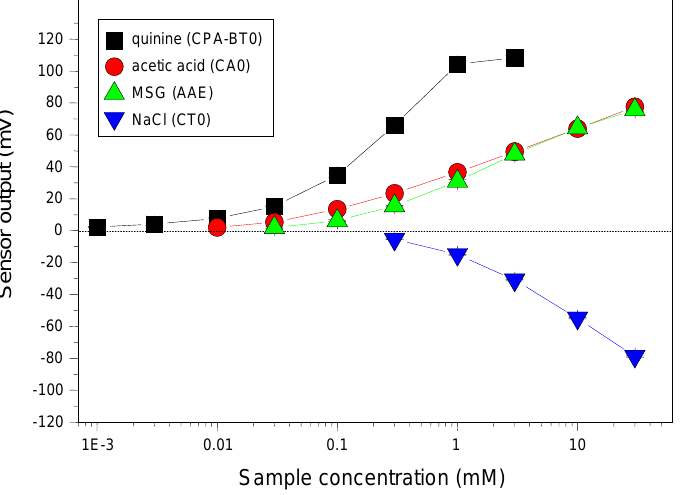
Figure 10. Concentration dependence of four taste sensors on taste substance. The relative values of sensors CA0, AAE, and CT0 were used for acetic acid, monosodium glutamate (MSG), and NaCl, respectively, while the CPA value of sensor BT0 was used for quinine hydrochloride. Data are expressed as mean ±SD (n = 4). All samples include 1 mM KCl as supporting